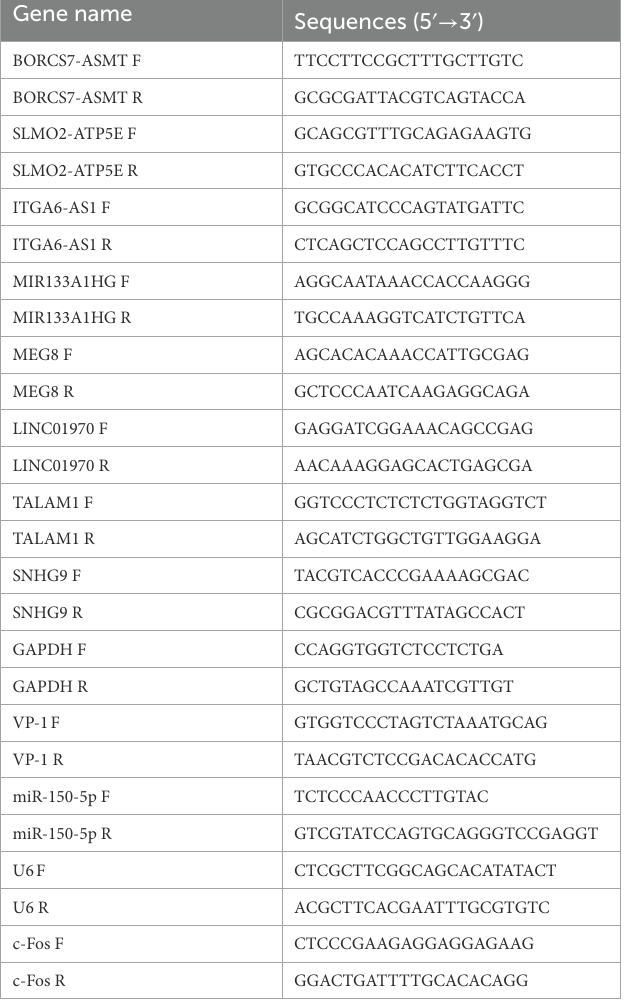
TABLE 2 Oligonucleotide primer sets for